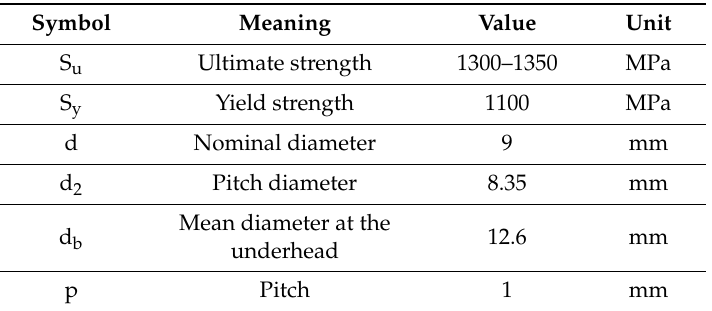
Table 2. Main features of the tested